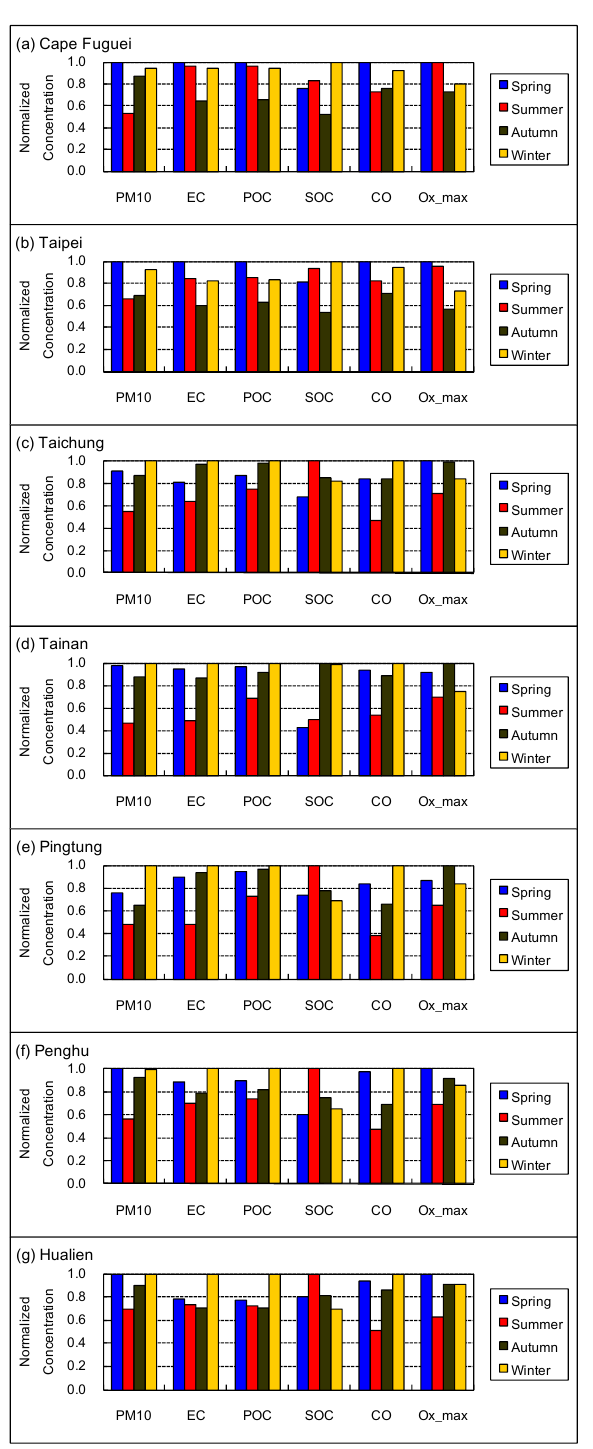
Fig. 6. Seasonal variations in the mass concentrations of carbona- ceous components of PM 10 at the respective network stations. The variations in PM 10 , CO, and daily oxidant maximum (Ox max) are illustrated for reference. Note that, for the purpose of visualization, the seasonality of each species is illustrated in terms of normalized concentration.